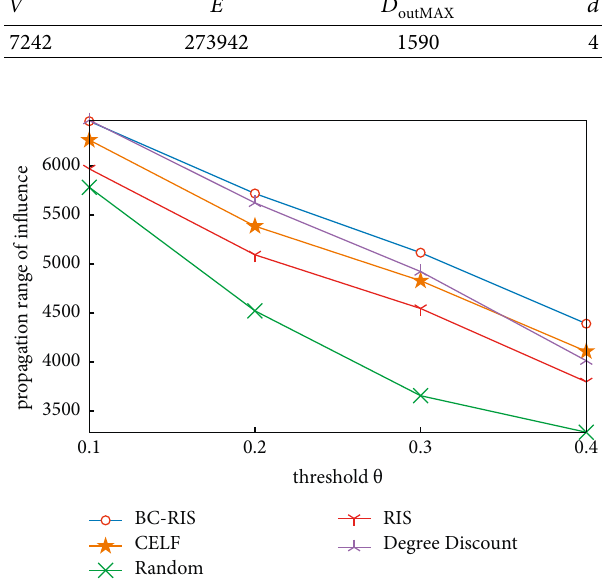
Figure 4: Positive influence propagation range of different in- fluence maximization algorithms, and number of seed nodes is 20.